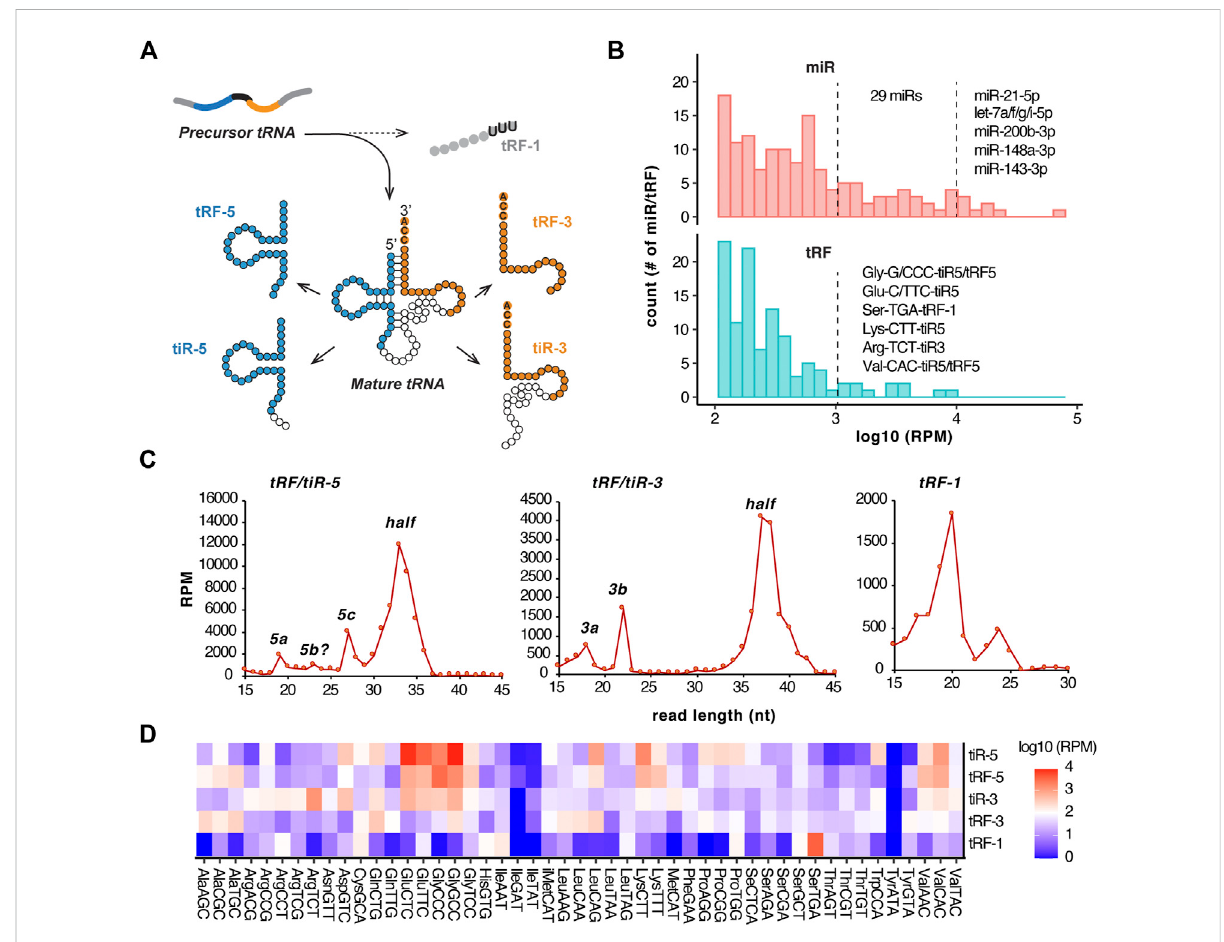
FIGURE 3 Abundant tRFs show distinct size distribution. (A) Major subtypes of tRFs. (B) Comparison of relative abundance of microRNAs and tRFs by histogram( X -axis:log10scaleofreadspermillion).TopexpressedmiRsandtRFs(RPM > 1,000)arelabeled.tRFisgroupedbyeachofthe fi vetypesin (A) and further by anticodon. (C) Size distribution ( X -axis in nucleotides, Y -axis in reads per million mapped reads) of each tRF subtype. (D) tRF abundanceshown as aheatmap grouped bytRFtypes and anticodons. RPM valuesare averaged from 12 samples (individual samples plotted in Supplementary Figure